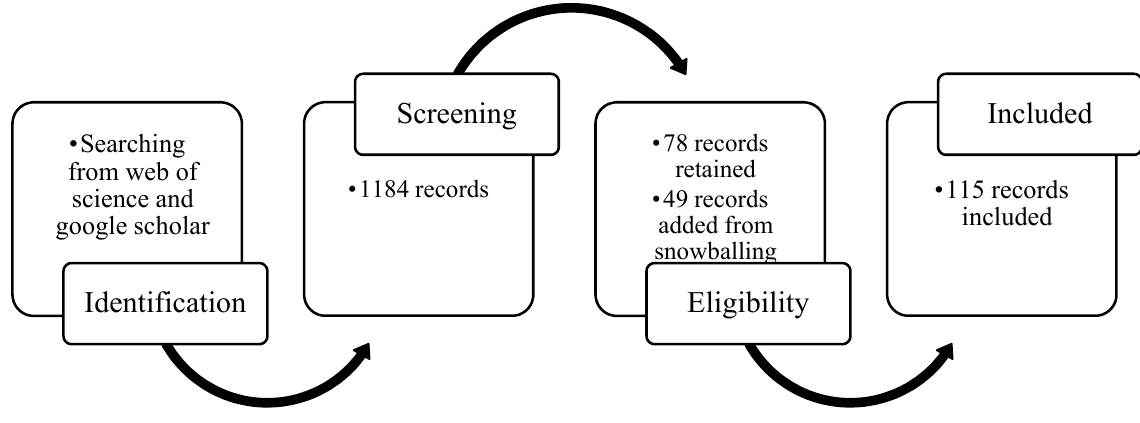
Figure 2. Flowchart of the systematic